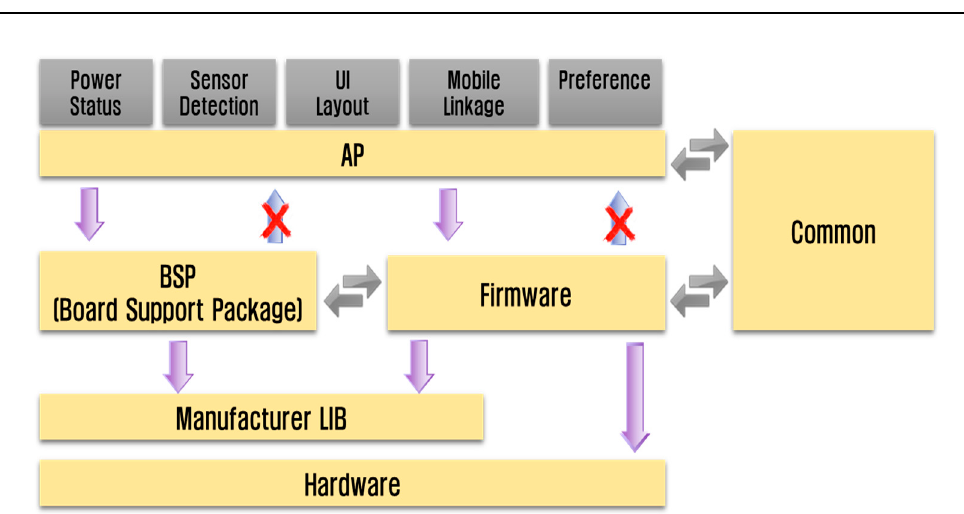
Figure 5. Firmware design of the proposed DiverPAD. Algorithm 1 DiverPAD firmware logic